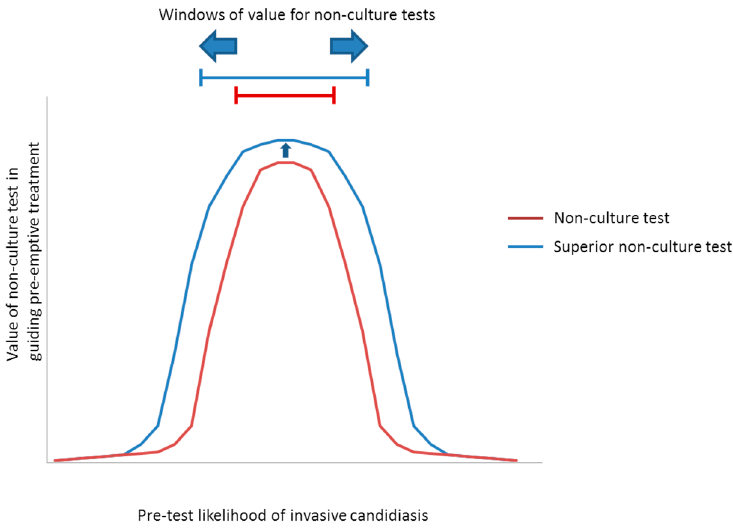
Figure 2. Schematic representation of the value of non ‐ culture diagnostic tests in guiding antifungal treatment strategies. Data from Table 2 can be applied to the paradigm of Figure 1 to identify the range of pre ‐ test likelihoods (windows) in which non ‐ culture tests are predicted to be useful. If tests are performed in settings with very low incidence of invasive candidiasis, PPVs generally are too low to justify antifungal treatment and NPVs do not add significant marginal value over simply knowing the pre ‐ test likelihood. As pre ‐ test likelihood increases, improved PPVs hit a threshold at which pre ‐ emptive treatment is beneficial. NPVs remain sufficiently high that antifungal treatment can be deferred without undue probability that invasive candidiasis is present. At some higher pre ‐ test likelihood, however, NPVs hit a threshold at which the probability of invasive candidiasis is too high to forego antifungal treatment. The window in which non ‐ culture tests promote pre ‐ emptive treatment is defined by the pre ‐ test likelihoods associated with threshold PPVs and NPVs (represented by bars in figure). A superior test (represented in blue) broadens the window compared to an inferior test (represented in red) by improving PPV and/or NPV, thereby dropping the low ‐ end and/or raising the high ‐ end pre ‐ test likelihood (as shown by horizontal blue arrows). A superior test also has greater value in screening due to its higher PPV and/or NPV at a given pre ‐ test likelihood (as shown by small vertical blue arrow).